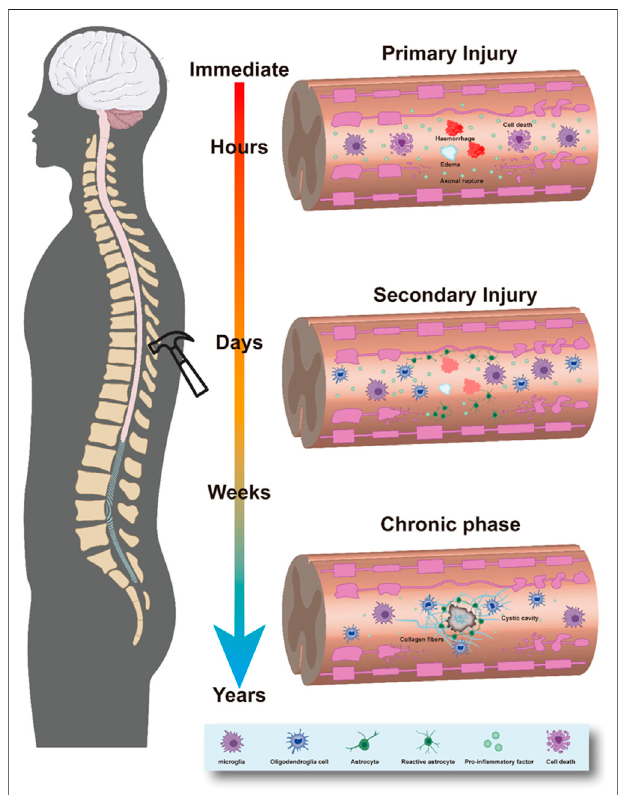
FIGURE 1 | Pathological process of SCI. This process consists of three phases, the primary phase, secondary phase, and chronic phase.